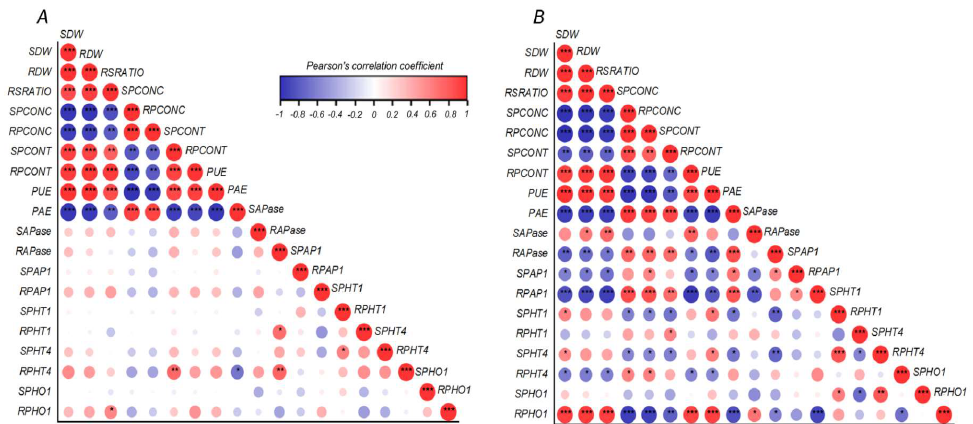
Figure 4. Pearson’s correlation coefficient matrix among growth, biochemical and molecular param- eters of ryegrass cultivars hydroponically grown at optimal (0.1 mM P; ( A )) and deficient (0.01 mM P; ( B )) P conditions. Pearson’s coefficient * p ≤ 0.05, ** p ≤ 0.01, *** p ≤ 0.001. Positive and negative correlations are distinguished by blue and red colors, respectively. Abbreviations: phosphorus acquisition efficiency (PAE), phosphorus utilization efficiency (PUE), shoot dry weight (SDW), root dry weight (RDW), root:shoot ratio (RSRATIO), shoot P concentration (SPCONC), root P concentra- tion (RPCONC), shoot P content (SPCONT), root P content (SPCONT), shoot LpPHT1;1 expression (SPHT1), root LpPHT1;1 expression (RPHT1), shoot LpPHT1;4 expression (SPHT4), root LpPHT1;4 expression (RPHT4), shoot LpPHO1;2 expression (SPHO), root LpPHO1;2 expression (RPHO), shoot LpPAP1 expression (SPAP1), root LpPAP1 expression (RPAP1), shoot APase activity (SAPase) and root APase activity